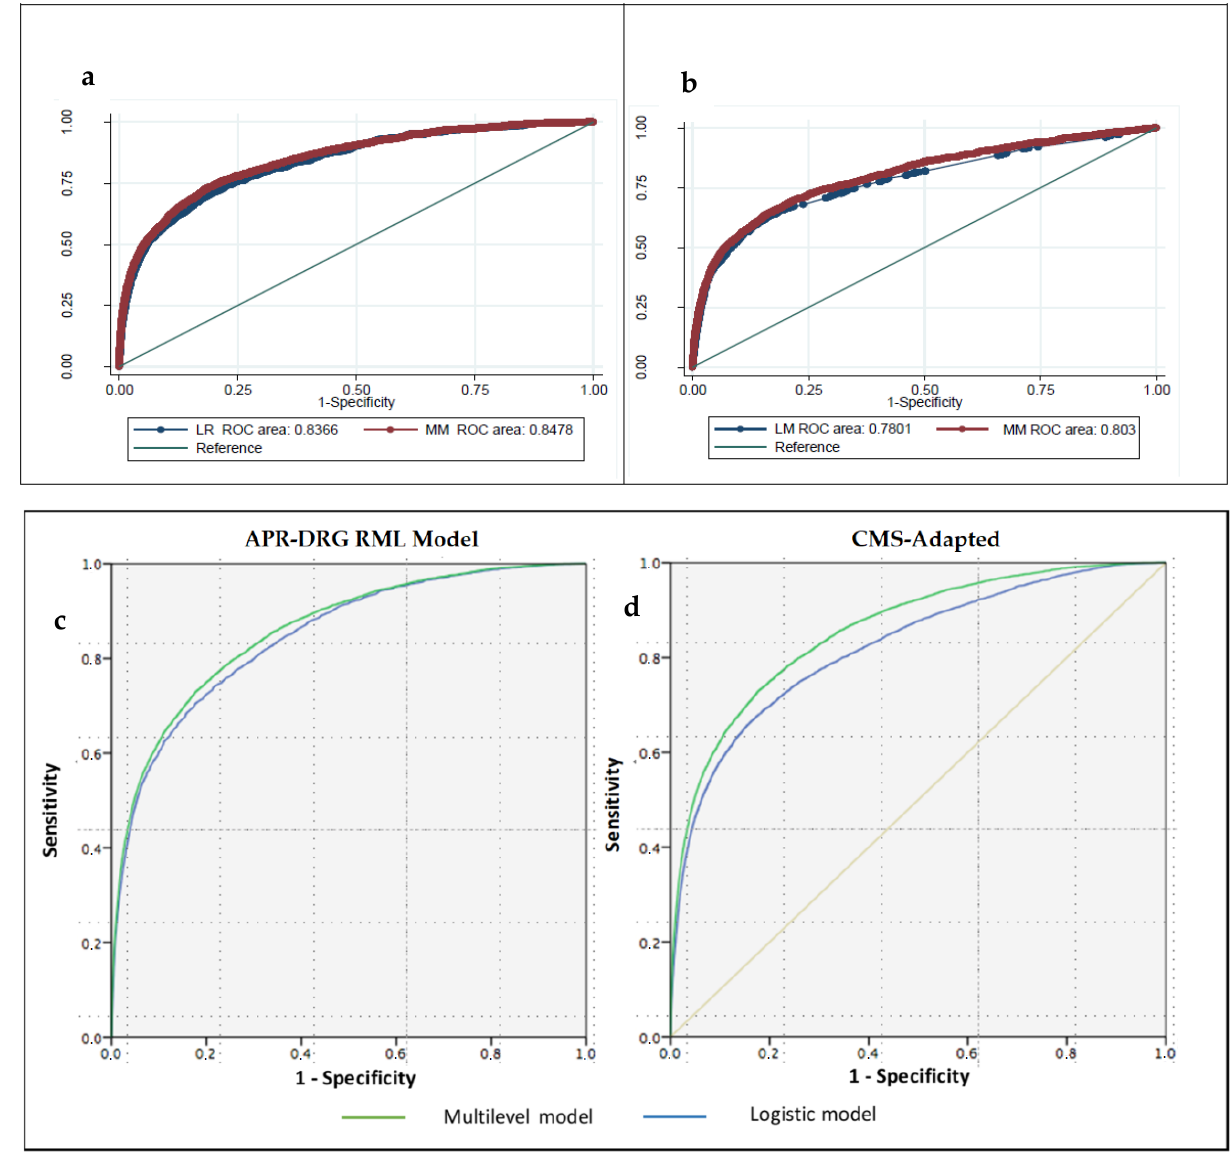
Figure 1. ROC curves of in-hospital mortality risk adjustment. APR-DRG RML and CMS-adapted models ( a ) and ( b ) Receiver-operating characteristics (ROC) curves of in-hospital mortality risk adjustment, ( c ) APR-DRG risk mortality level (RML) and ( d ) Centers for Medicare and Medicaid Services (CMS)-adapted models.